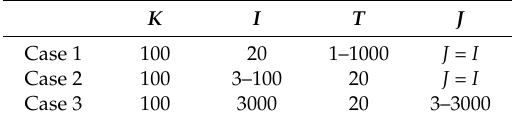
Table 1. The parameters used for simulations.